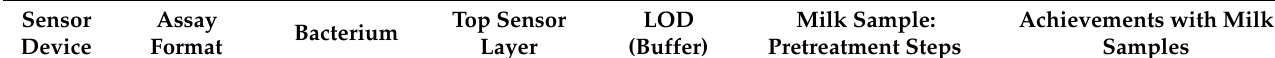
Table 4. Detection of probiotic and pathogenic bacteria in cow’s milk with QCM sensors and EMPAS devices without the use of sample enrichment methods other than spiking or